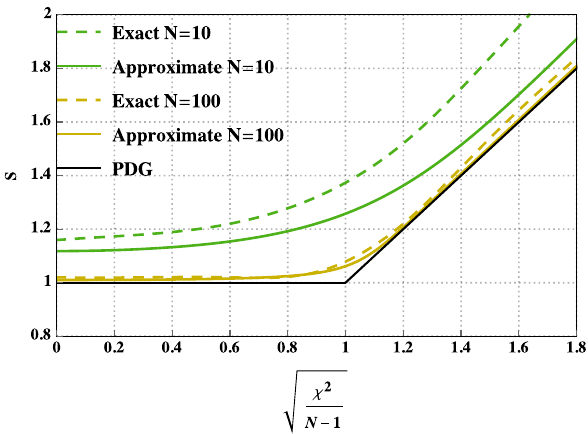
Fig. 5 Comparison of the exact result with the approximate formula for α =